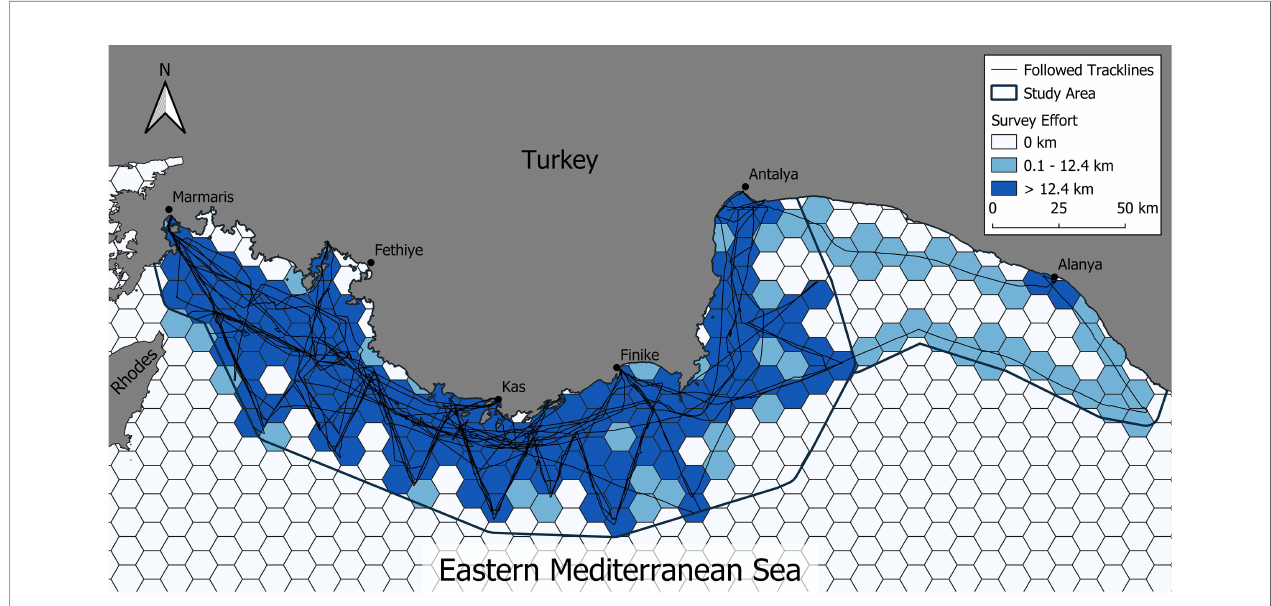
FIGURE 2 | Survey effort in kilometres covered by the research vessel per cell in the Eastern Mediterranean Sea surrounding Turkey with darker blue cells showing areas with more than 12.408km of boat track line (suitable for encounter rate analysis), lighter blue cells showing less than 12.408km and white cells showing no survey effort.